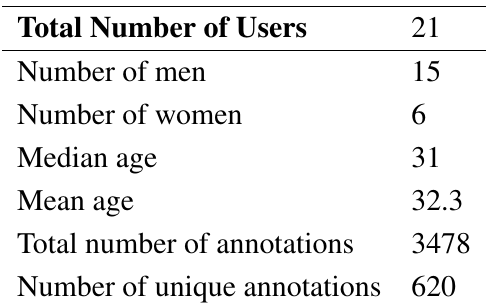
Table 1. Data trial